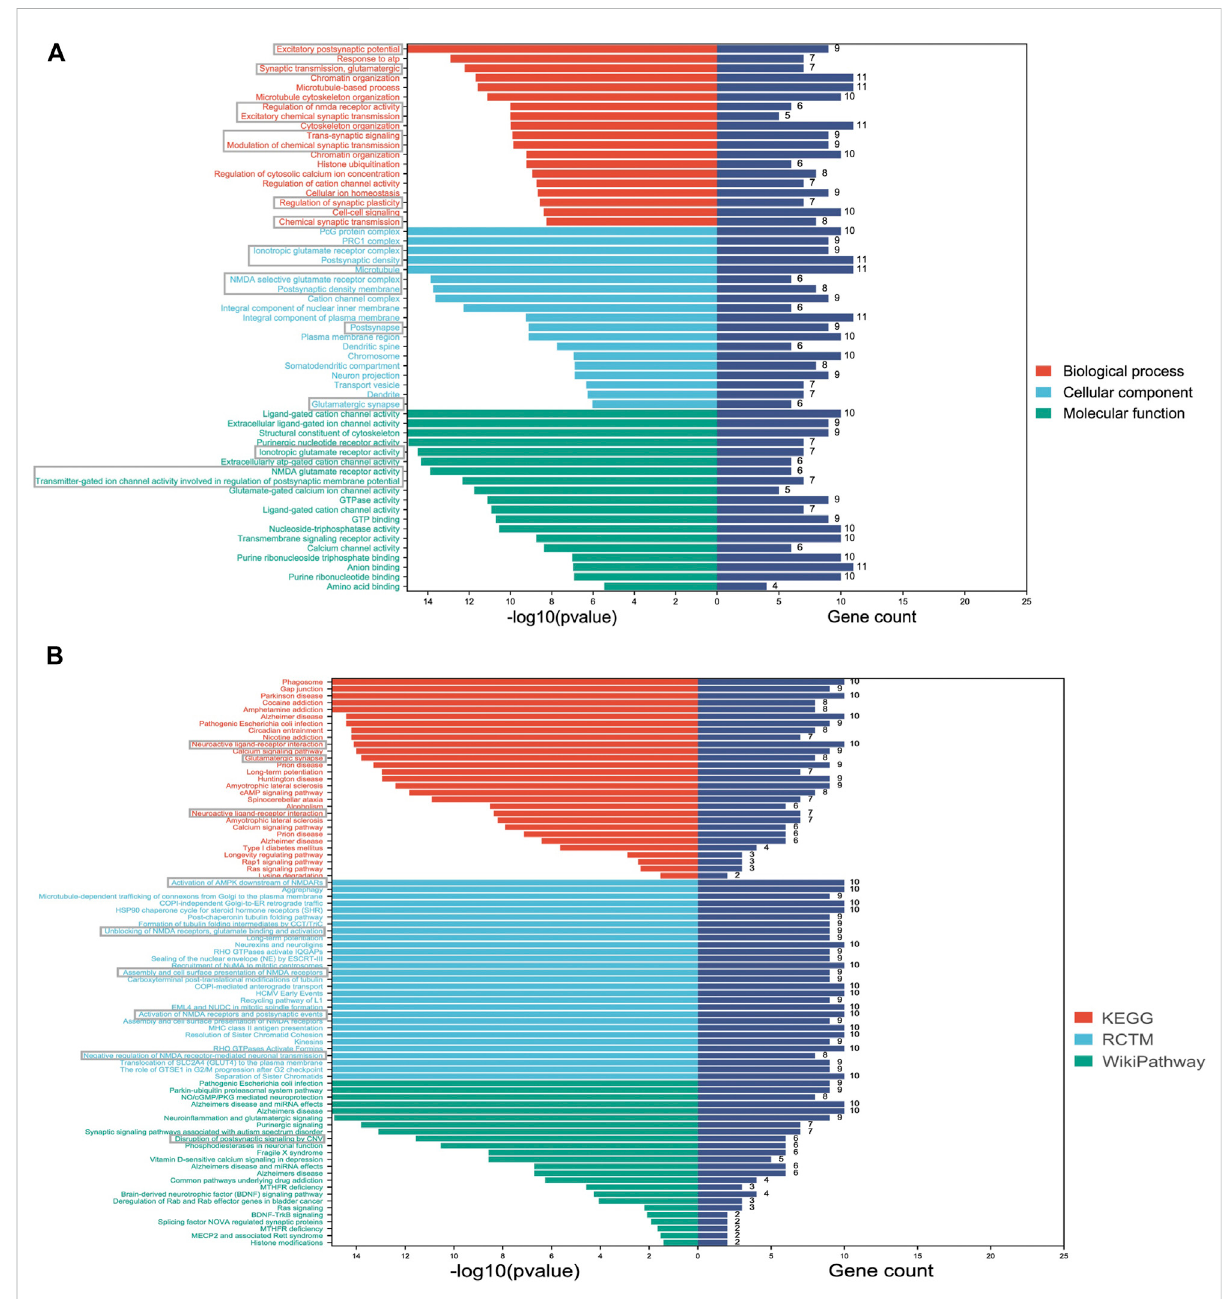
FIGURE 4 Signi fi cantly enriched GO and pathway terms of DMR-related genes. (A) The Y -axis represents the GO terms and the X -axis represents the p values and gene count of enrichment; (B) The Y -axis represents the pathway terms and the X -axis represents the p values and gene count of enrichment. Synaptic and glutamate function-related terms are labeled with grey